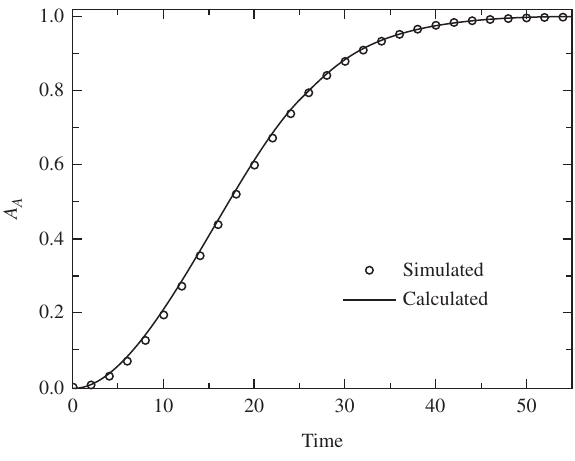
Figure 1. Area fraction, A , against time. Simulation results are in agreement A with those calculated from the kinetics of a single grain, Equation